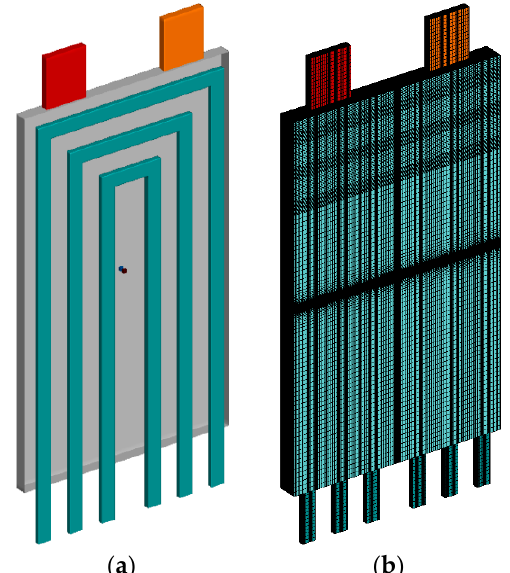
Figure 10. Schematic of ( a ) geometry; ( b ) mesh for internal shorting modeling of lithium-ion battery cooled by mini-channel cold plate.